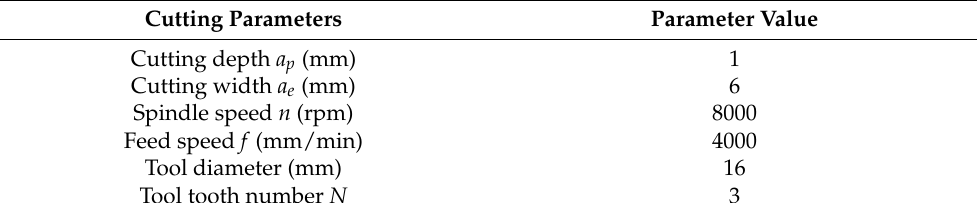
Table 3. Cutting parameters [2].